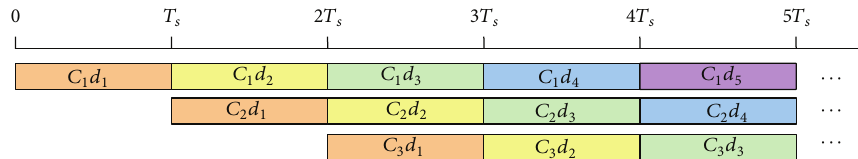
Figure 1: The code-time diversity system with 3 orthogonal spreading